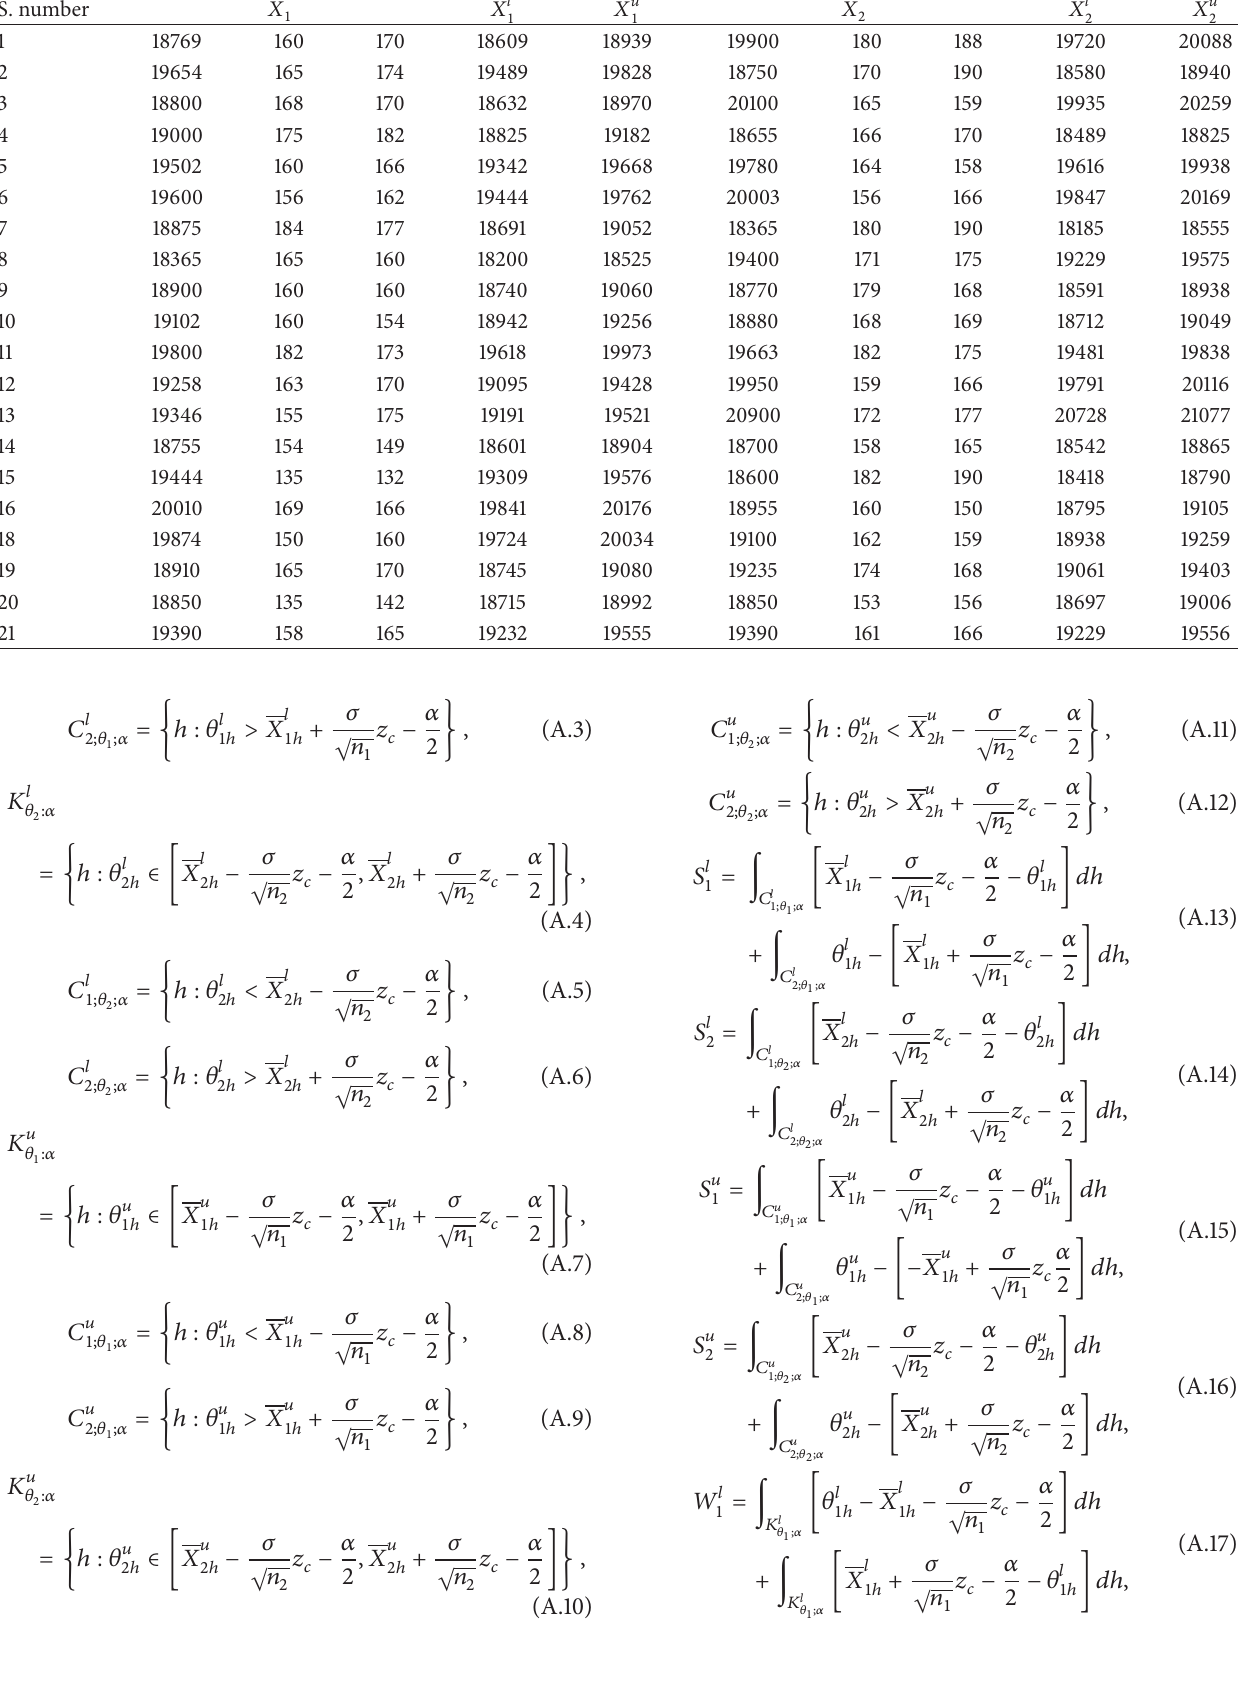
Table 1: The rough values of 𝑋 𝑙 𝑖𝑗 and 𝑋 𝑢 𝑖𝑗 (app.) of two groups are explained briefly by the following table through triangular fuzzy numbers. S.